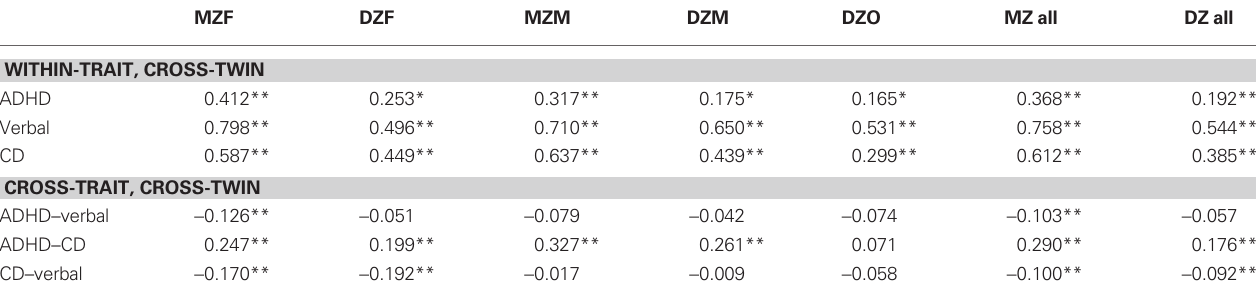
Table 3 | Within- and cross-trait, cross-twin